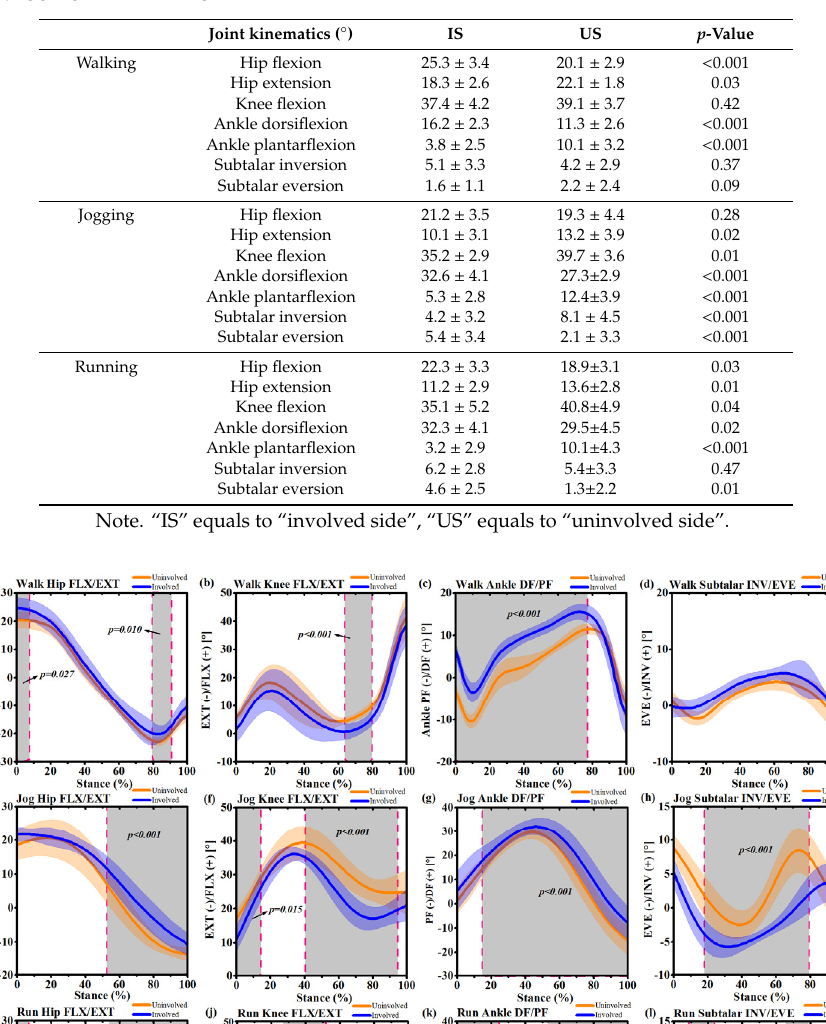
Table 2. The peak joint kinematics of the involved side (IS) and the uninvolved side (US) during walking, jogging and running movements.